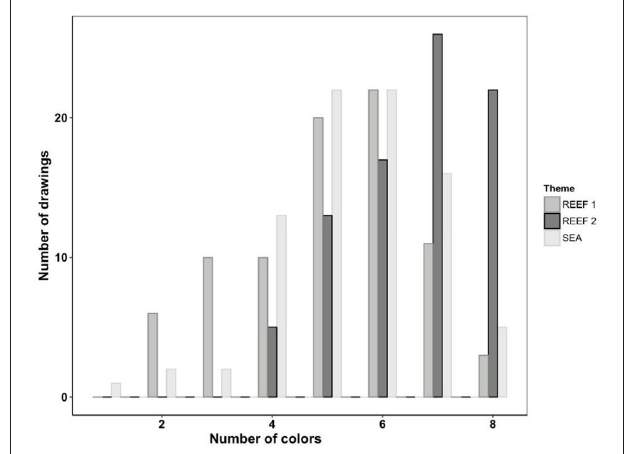
FIGURE 4 | Evolution in the number of colors used according to the themes (Sea, Reef1 and Reef2). Axes: number of colors vs. number of drawings.